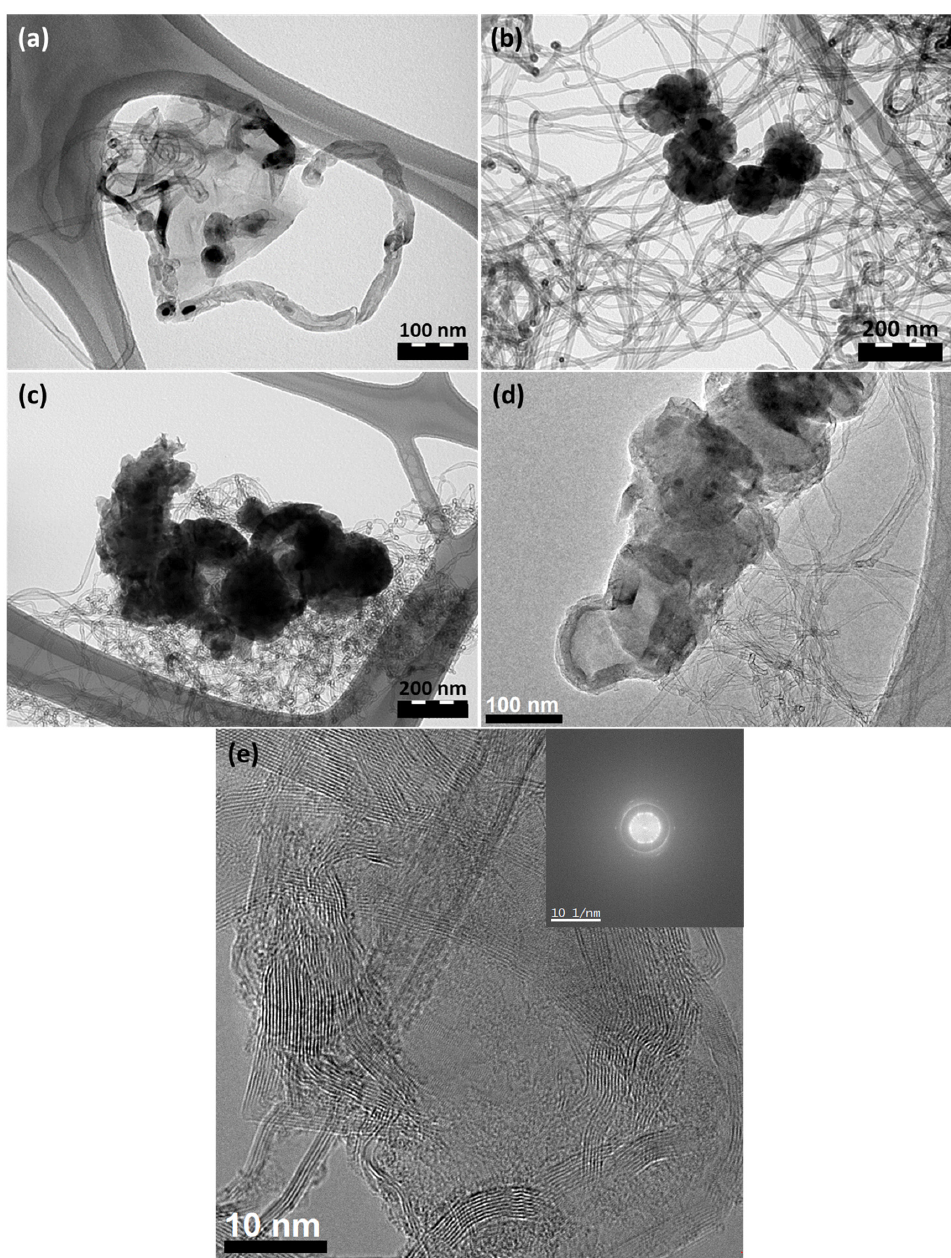
Figure 1. TEM micrographs of ( a ) carbon nanotubes (CNTs) growing out of the surface of a few-layer graphene (FLG) flake—method-1 (scale bar = 100 nm); ( b ) CNTs and FLG grown from a mixture of AlCoFeO 4 and CoFe 2 O 4 catalysts, respectively—method-2 (scale bar = 200 nm); ( c ) (scale bar = 200 nm) and ( d ) (scale bar = 100 nm) FLG-CNT hybrid material grown from a single catalyst (Al 0.025 Co 0.975 Fe 2 O 4 )—method-3; ( e ) high-resolution transmission electron microscopy (HRTEM) micrograph of the hybrid shown in ( c ) and ( d ) (scale bar = 10 nm); inset shows the corresponding electron di ff raction